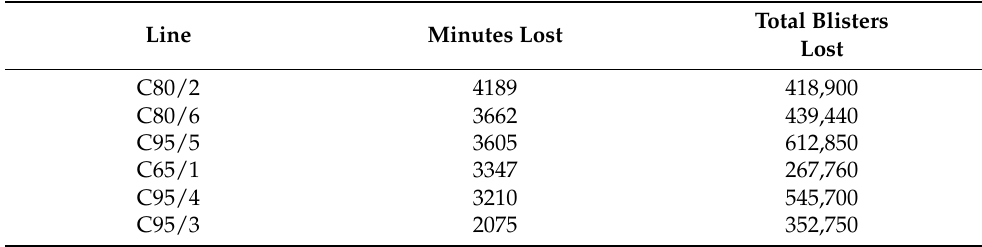
Table 4. The downtime in terms of minutes lost and blisters lost before the project was eliminated once the corrective actions were taken. This table demonstrates the amount of waste in the process prior to the